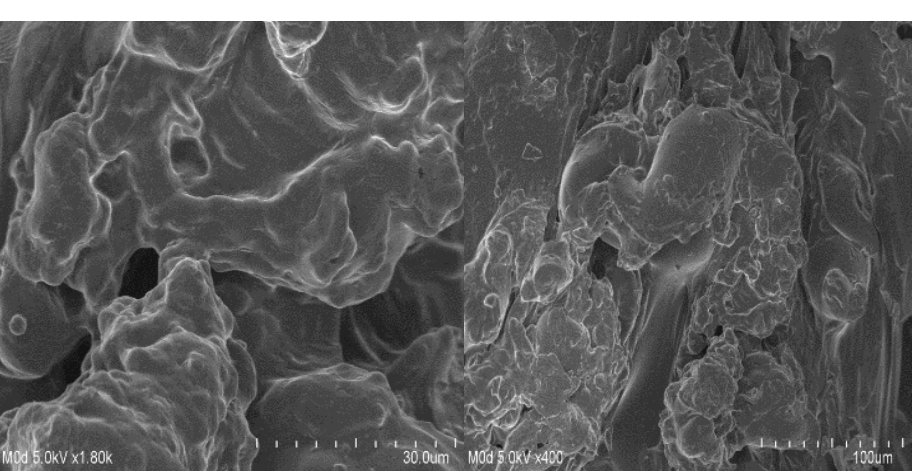
Figure 7. Surface morphology of ASP/ALPAA hydrogels.